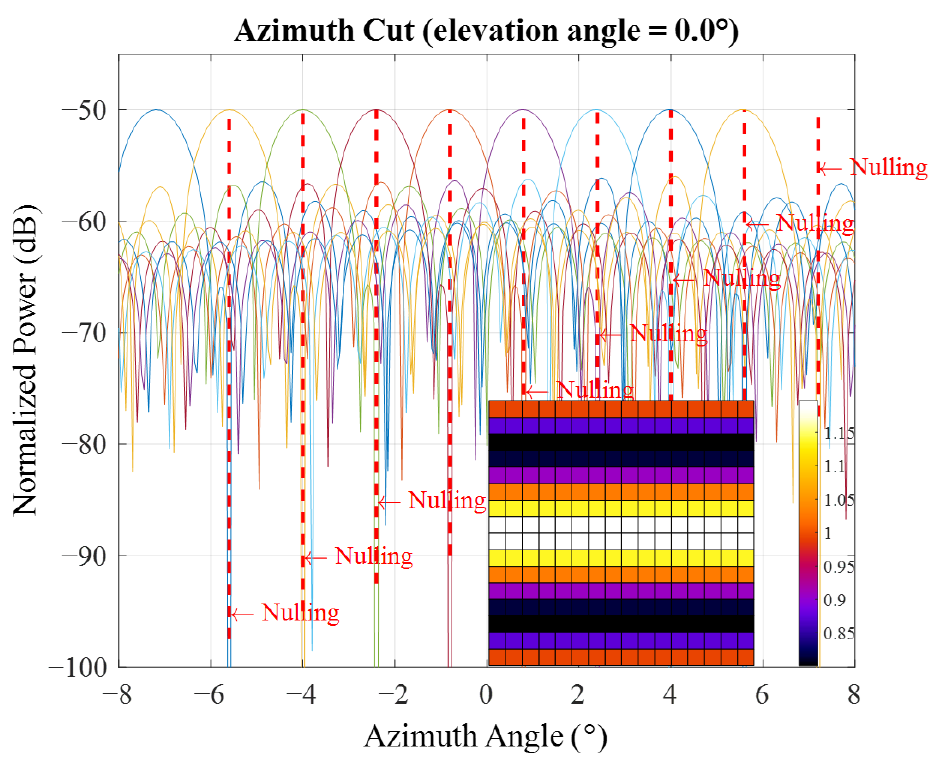
Figure 9. Azimuth cut of 16 × 16 subarrays in a multibeam scenario with nulling between